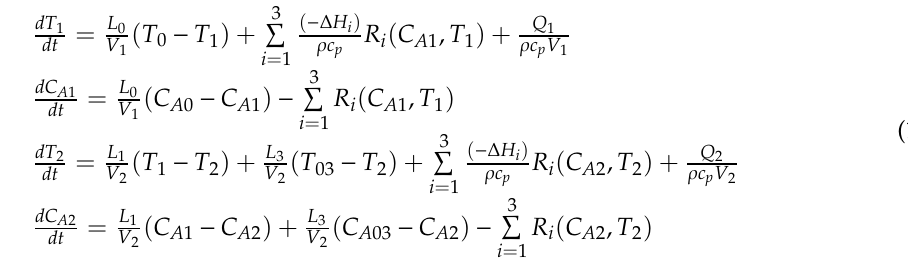
Reactor 2 Figure 4. Schematic of continuous stirred tank reactors (CSTRs).